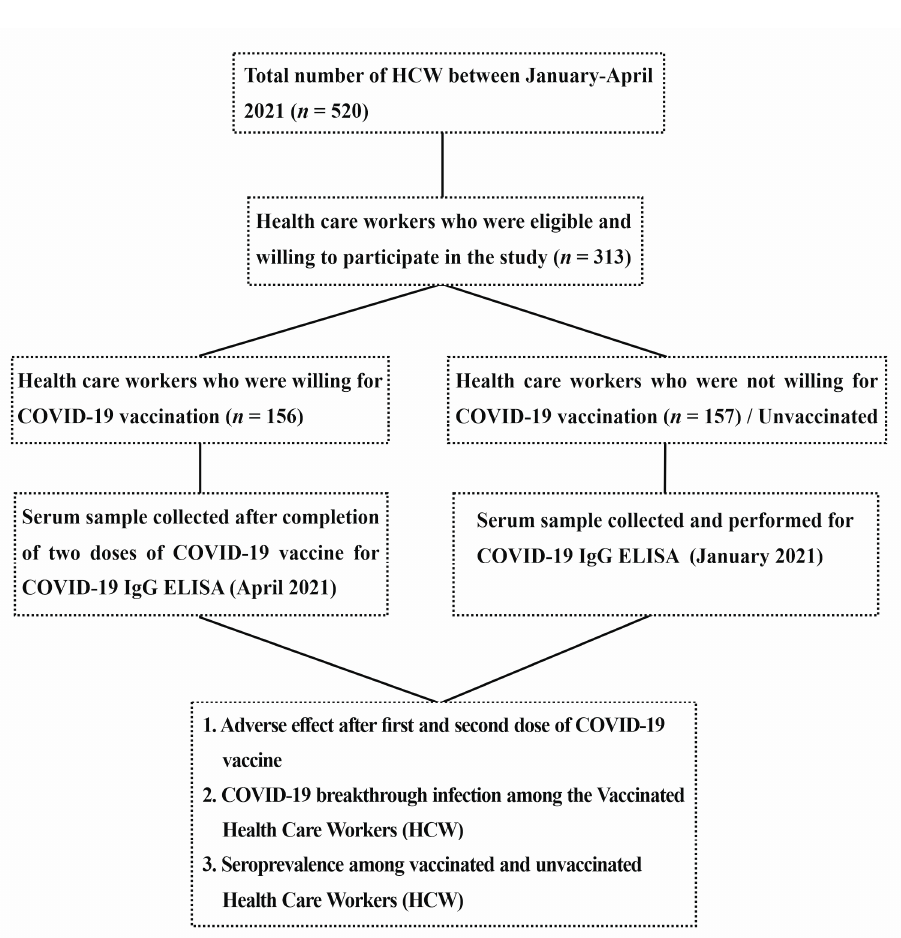
Figure 1. Study flow diagram.